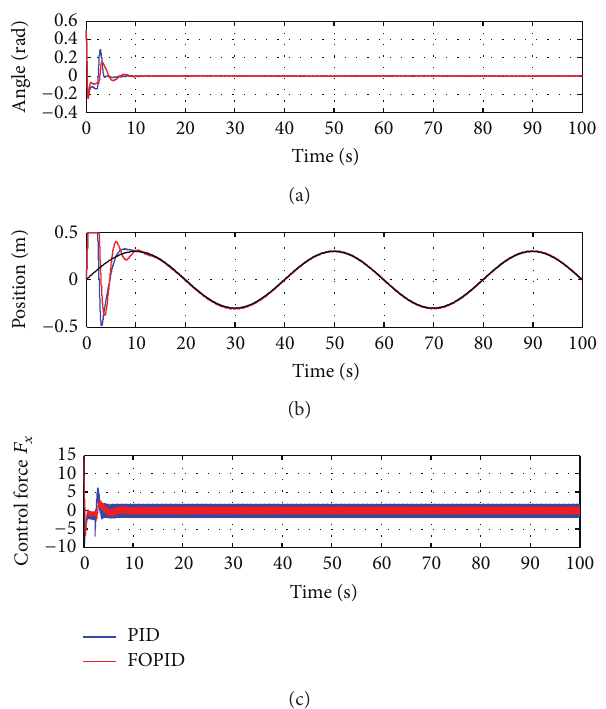
Figure 9: Tracking of inverted pendulum (with disturbances 𝑑 1 = = 20 sin (20𝜋𝑡) 𝑑 2